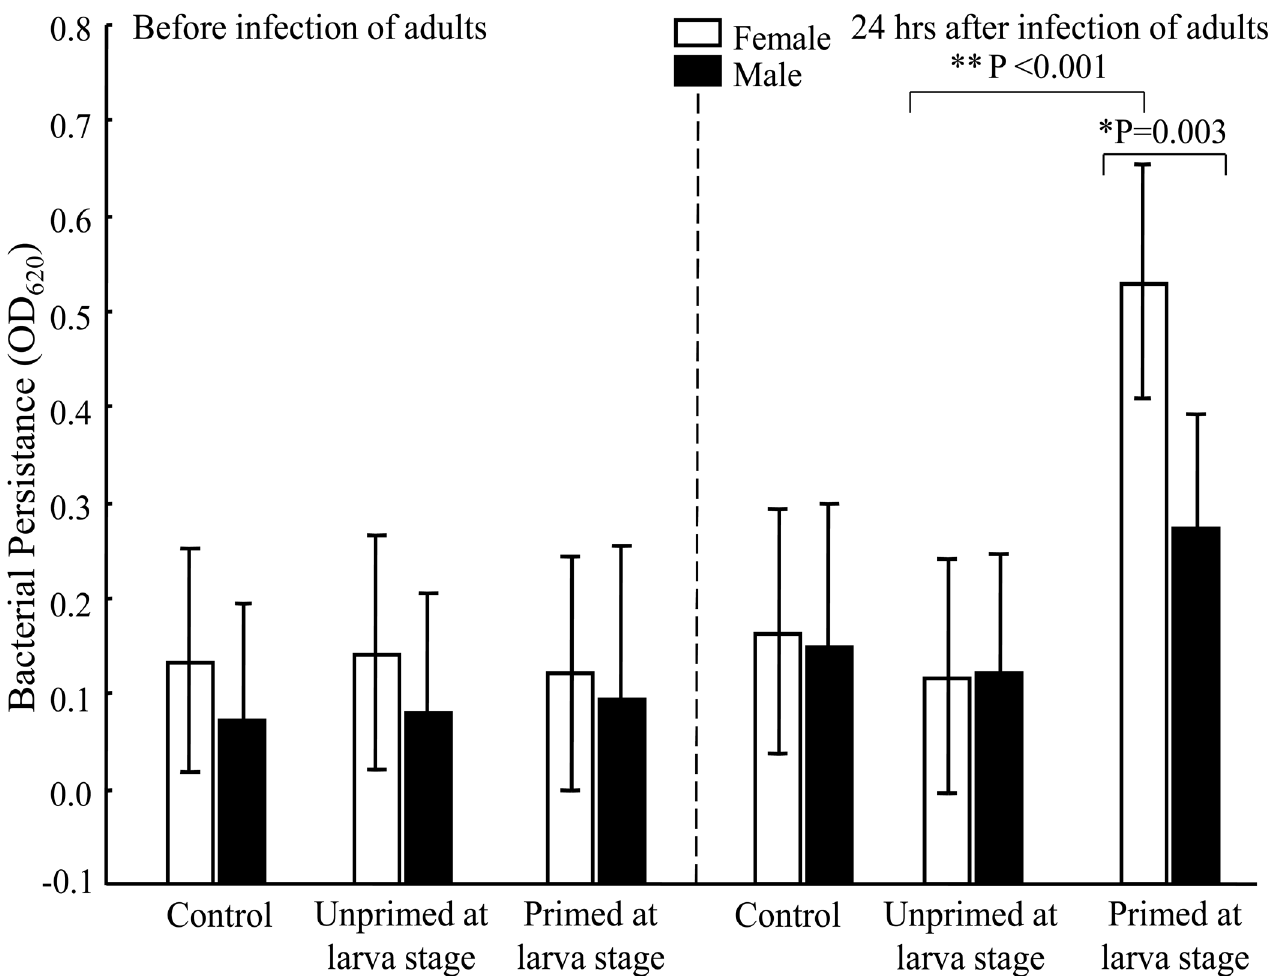
Fig 7. E . coli persistence after infections. Persistence was defined as the turbidity intensity of culture in LB. ( * ) indicates a significant difference between genders within each treatment group (C, UnPr, Pr); ( ** ) indicates a significant difference between UnPr and Pr females 24 h after infection of adults. Number of samples per group before infection: ♀ = 10, ♂ = 6 for C; ♀ = 11, ♂ = 10 for UnPr; ♀ = 10, ♂ = 10 for Pr. Number of samples per group after infection: ♀ = 9, ♂ = 7 for C; ♀ = 10, ♂ = 10 for UnPr; ♀ = 10, ♂ = 10 for